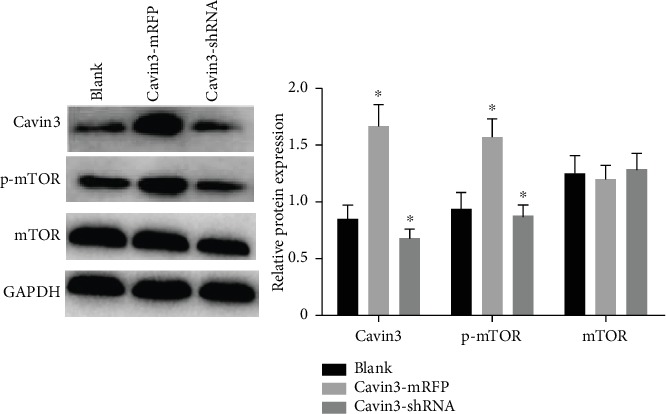
Effect of Cavin3 expression on the mTOR signaling pathway in lung cancer cells. (a) Protein bands of mTOR pathway-related proteins and (b) corresponding expression levels (∗ means p < 0.05, N = 200).